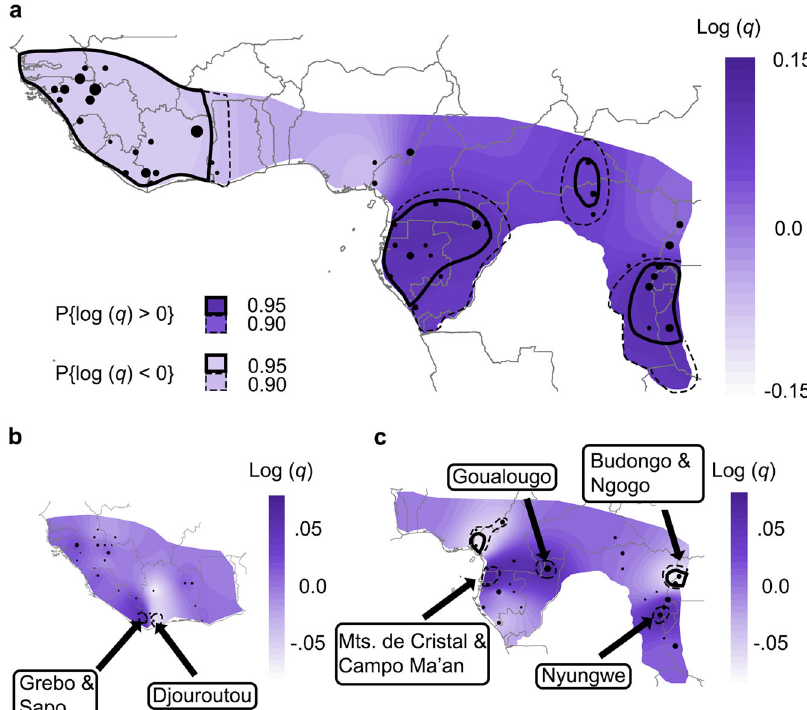
Fig. 4 EEMS diversity rates in chimpanzees at different population scales. a Map of diversity rates ( q ) for the entire species. Diversity rates are mean centred (population average) on a log 10 scale, whereby a value of 1 equates to a tenfold rate increase over population mean rate. Point diameter is proportional to the number of individuals sampled in a given deme (range = 1 – 72). Solid black lines indicate areas where the posterior probability of q differing from the mean rate is >95 percent and the dash lines highlight areas that are >90 percent. Lighter areas indicate populations where q is lower than the mean rate, and darker areas indicate populations where q is higher. Diversity rates were signi fi cantly lower in Pan troglodytes verus , while many of the populations in the P. t. troglodytes and P. t. schweinfurthii ranges had signi fi cantly higher rates. b Map of q in P. t. verus . Grebo and Sapo (Liberia) had signi fi cantly higher diversity rates than the average rate in P. t. verus and Djouroutou (Côte d ’ Ivoire) had signi fi cantly lower rates. Diversity at Mt. Sangbé (Côte d ’ Ivoire, white area) is also notably low, but not signi fi cant. c Map of q in P. t. ellioti , P. t. troglodytes and P. t. schweinfurthii (collectively ETS ). Several sites differed signi fi cantly, with P. t. ellioti sites